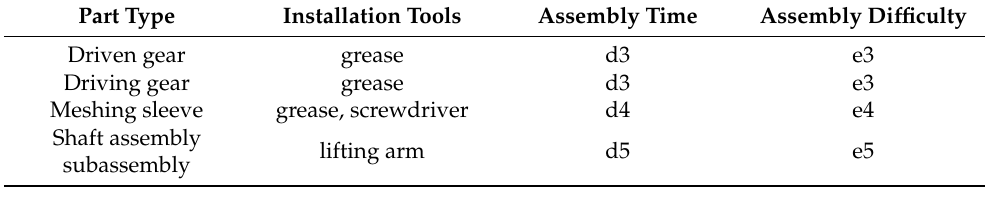
Table 7. Assembly sequence evaluation knowledge framework.